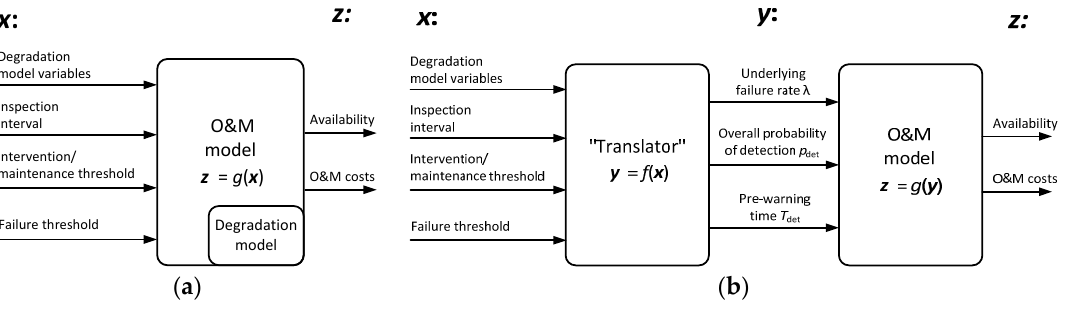
Figure 5. Illustration of the two integration approaches: ( a ) full integration; ( b ) loose integration.